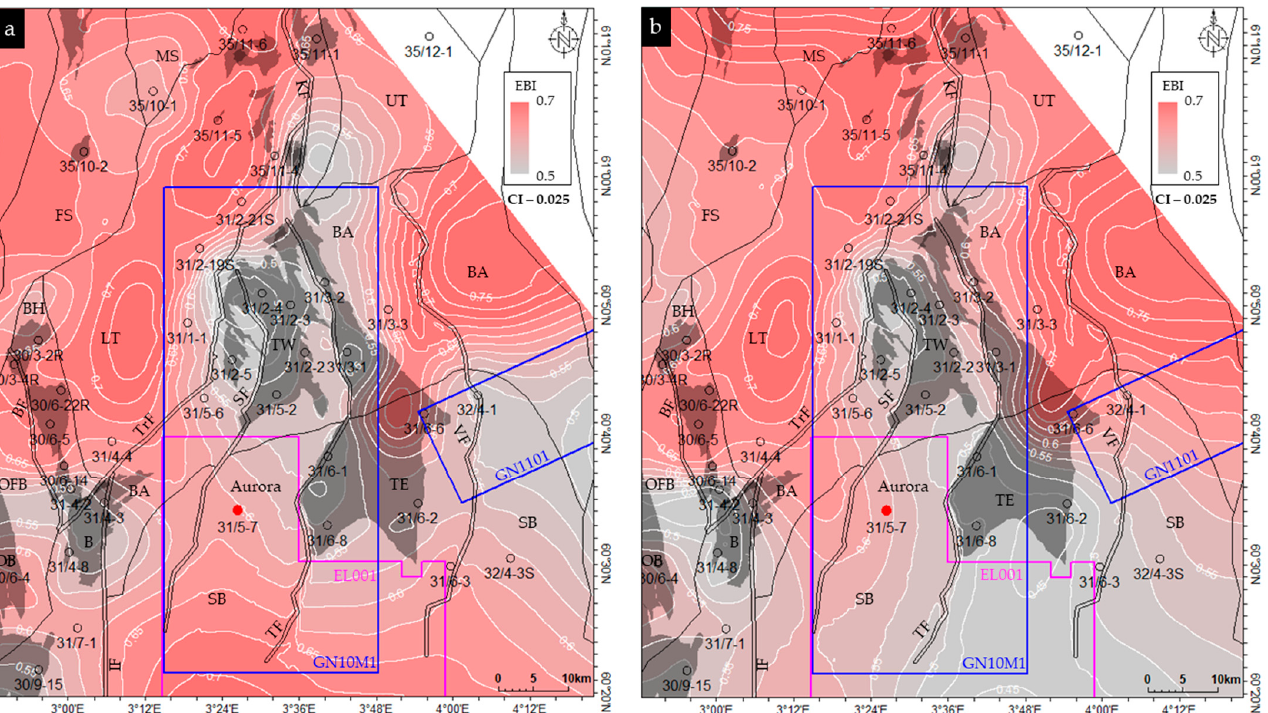
Figure 11. The property maps generated using the average well data of EBI of upper Drake ( a ) and lower Drake ( b ) units show the spatial variation of the caprock strength. The contour interval (CI) of each map is shown in the legend (0.025). Moreover, the grey shaded zones represent the oil and gas discoveries in the study